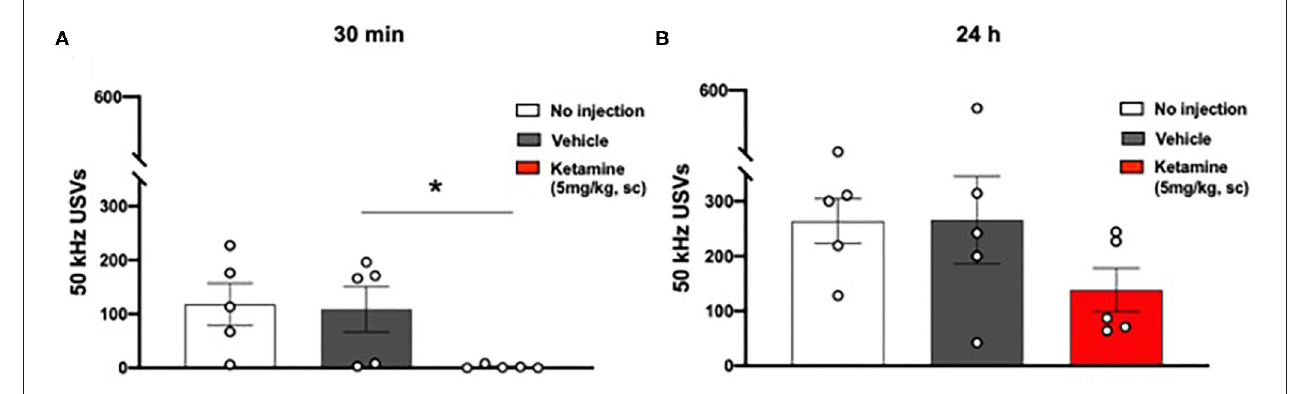
FIGURE 4 | Single administration of ketamine transiently reduced positive affect associated 50kHz USVs (30min) in WKY rats. (A) USVs 30min post-administration of ketamine (5 mg/kg, s.c.). (B) USVs 24h post-administration of ketamine (5 mg/kg, s.c.). Data are expressed as mean ± SEM, n = 5 cages of rats; n = 2 rats per